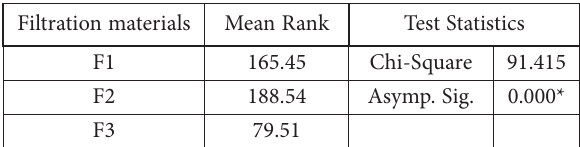
Table 6. Kruskal-Wallis rank test results of the measured